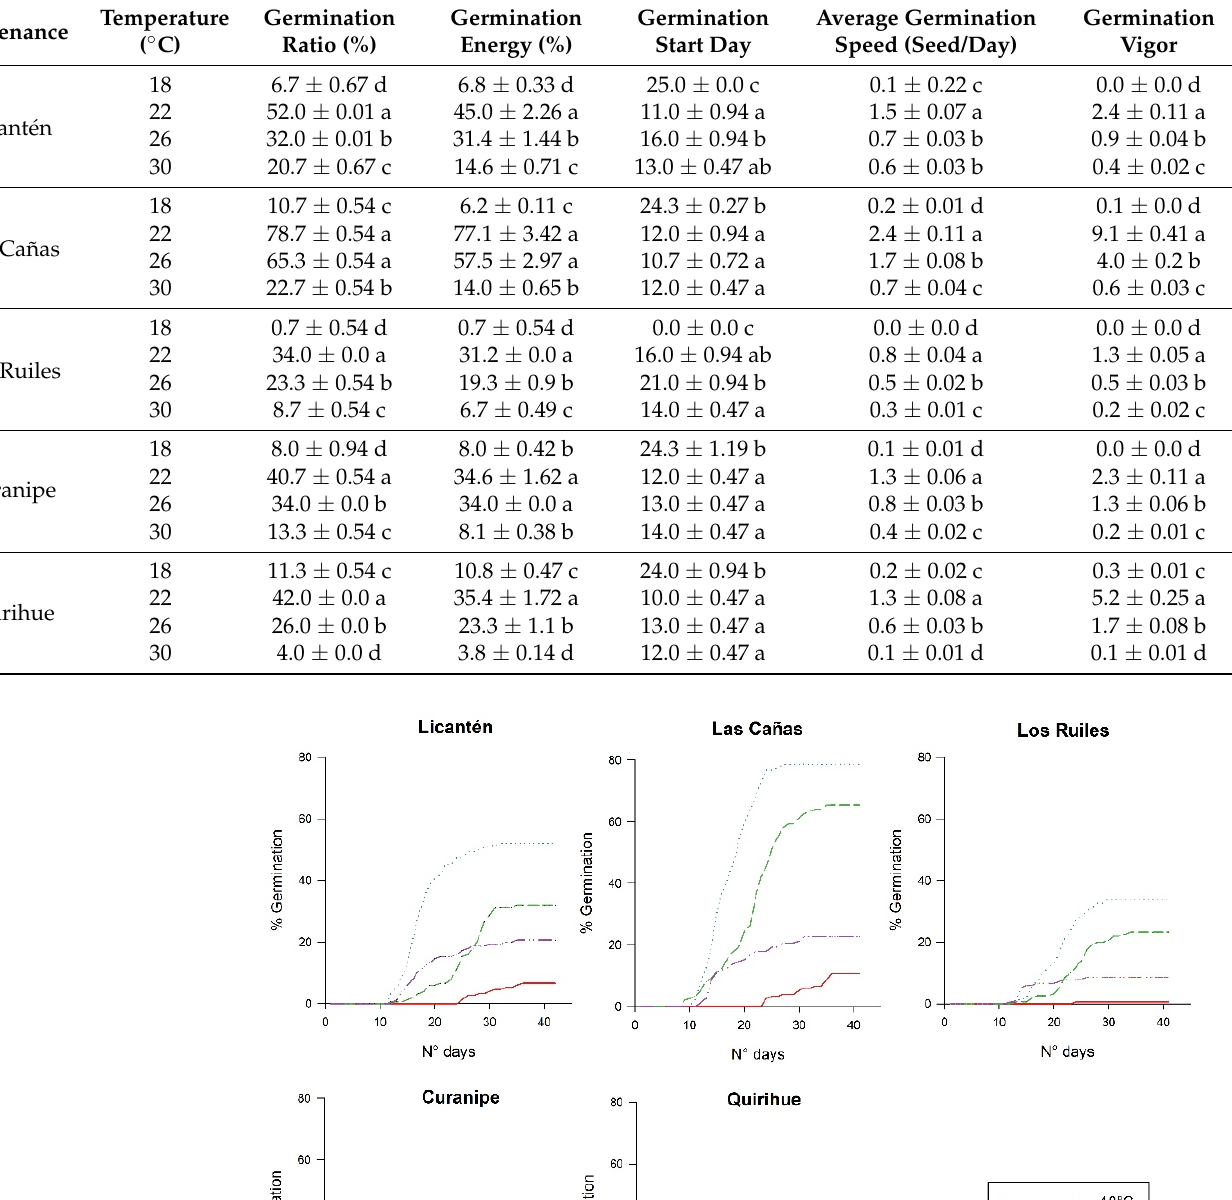
Table 1. Effect of temperature on different germination parameters of Nothofagus glauca (mean ± SE). Different letters indicate significant differences by Tukey’s multiple comparison test ( p < 0.05).